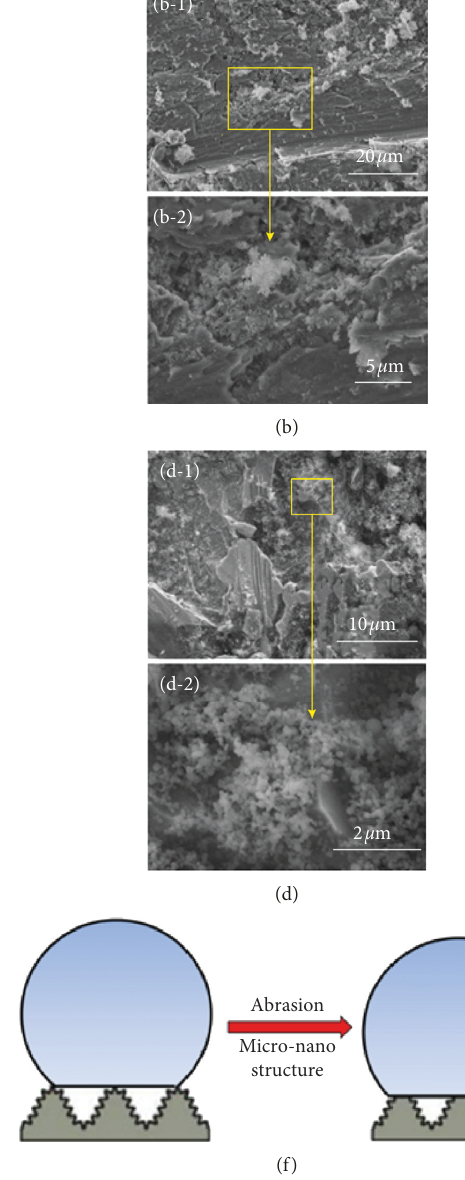
Figure 11: (a, b) MN-Al and (c, d) MN-SS surfaces slide at different distances after the low magnification and high-power FESEM images. The resistance abrasion schematic diagram of (e) nanostructured surface and (f) hierarchical structure